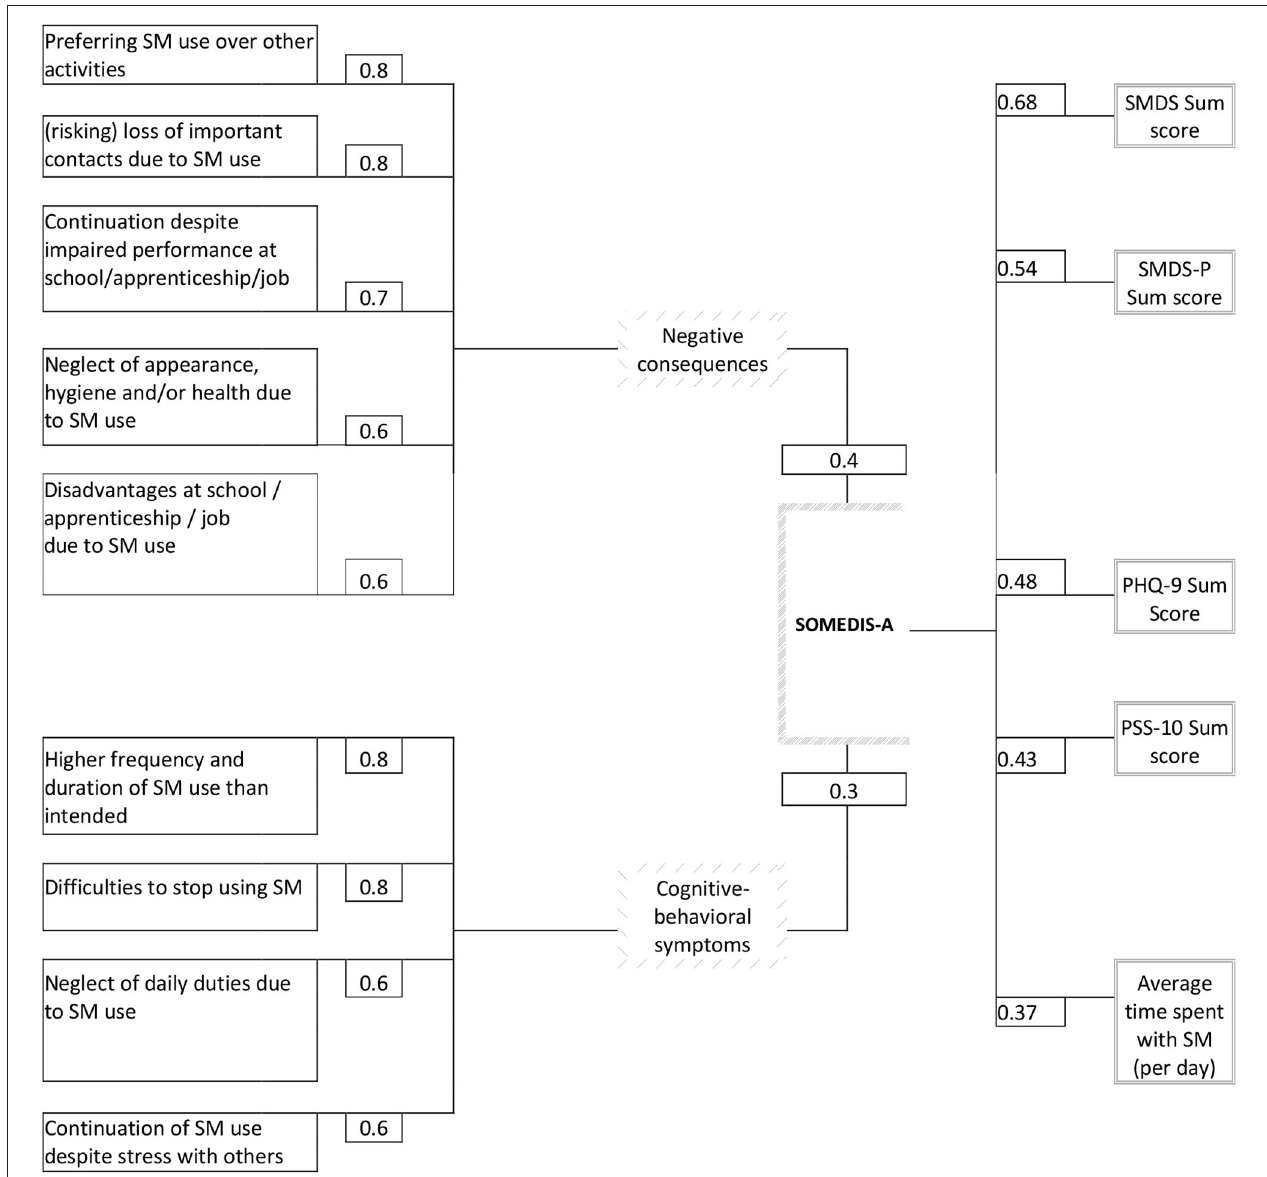
FIGURE 1 | EFA factor loadings on the latent SOMEDIS-A factor 1 (negative consequences) and SOMEDIS-A factor 2 (cognitive-behavioral SM use symptoms) are shown on the left [next to the individual scale item (manifest variable)] together with the proportion of explained variance (given above and below the SOMEDIS-A box). Correlation coefficients of the SOMEDIS-A sum score with criteria are presented on the right side (next to the criteria variables). All factor loadings and correlations were significant with p < 0.001. The usage days per week did not significantly correlate with the SOMEDIS sum score and are, thus, not depicted. SOMEDIS-A, Social Media Disorder Scale for Adolescents; SMDS(-P), Social Media Disorder Scale (Parental Version); SM, social media; PHQ, Patient Health Questionnaire; PSS, Perceived Stress